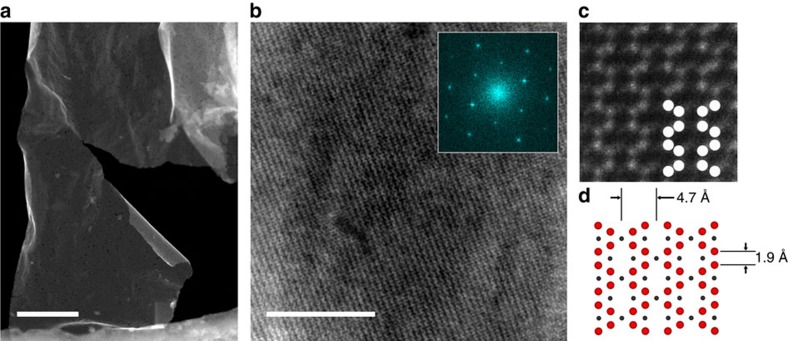
Top view of HAADF-STEM of single Mo1.33C sheet with ordered divacancies.(a) Low-magnification image of single flake with lateral dimensions >1 μm. (b) Higher magnification, with the FFT of the original image in (a) shown in the inset. (c) Atomically resolved image with overlaid schematic atomic structure in comparison to (d) ideal atomic structure from theoretically simulated parent MAX phase. The scale in c,d is identical. Scale bar in a corresponds 200 nm and scale bar in b corresponds to 10 nm.